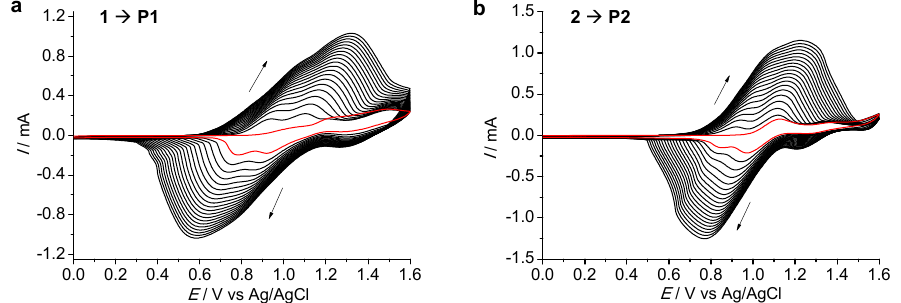
Figure 2. Cyclic voltammograms (CVs) recorded during the oxidative electropolymerization of ( a ) 1 and ( b ) 2 on an indium–tin-oxide (ITO) glass electrode by 20 repeated potential scan cycles between 0 and +1.6 V at 100 mV/s. The plots in red color are the first cyclic scan.